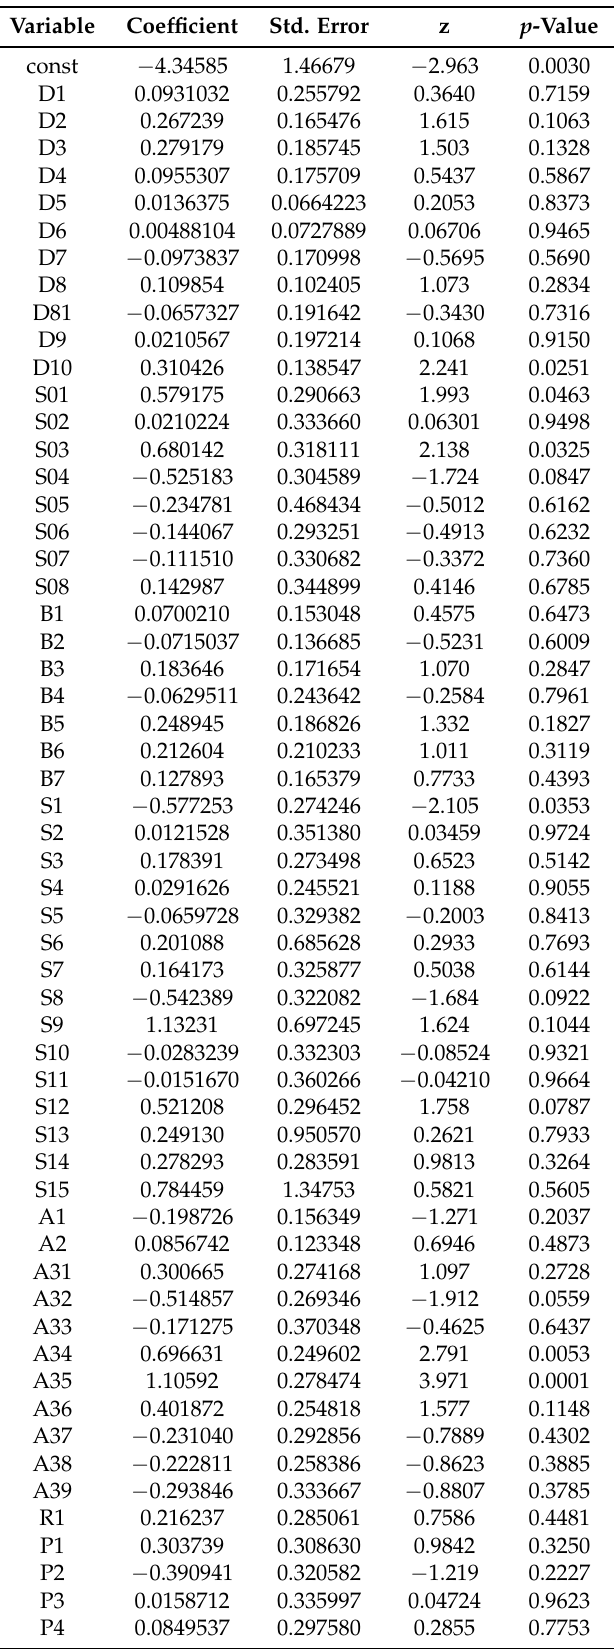
Table A2. Results of initial Logit Regression Model for Dependent variable: K1 (Standard errors based on Hessian) for determination of Y i